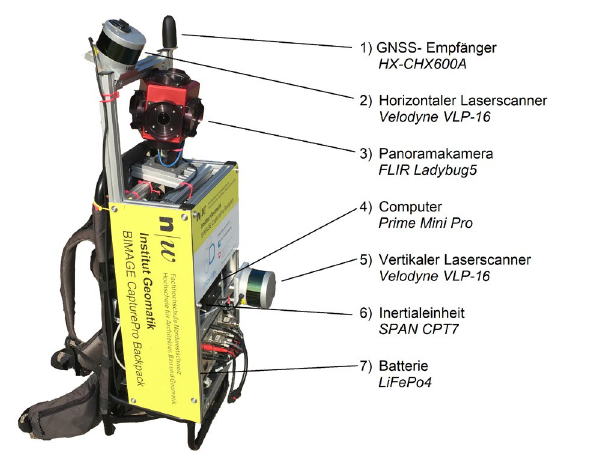
Figure 4. BIMAGE Backpack (Blaser et al., 2018). The BIMAGE Backpack, as most MMS, supports direct georeferencing based on GNSS and IMU measurements. The system also supports advanced georeferencing methods, either based on LiDAR SLAM or employing image-based techniques. With state-of-the-art image-based georeferencing, the BIMAGE Backpack can achieve accuracies of a few cm even in city centres (Blaser et al., 2020).